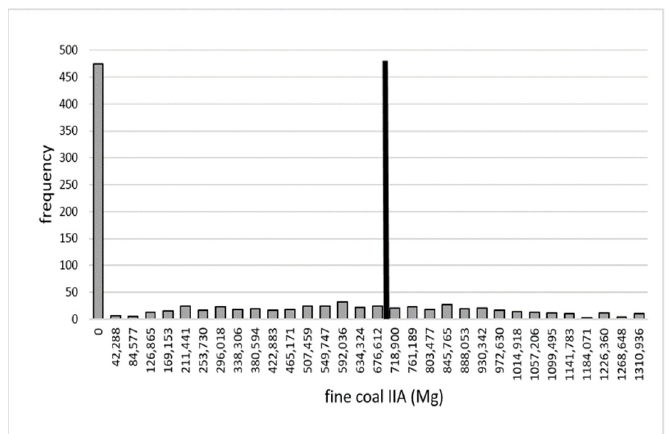
Figure A25. Histogram showing frequencies of achieving given quantity of sales of fine coal IIA (“Indv. consumers 2”) for mine “G” with σ yprog .